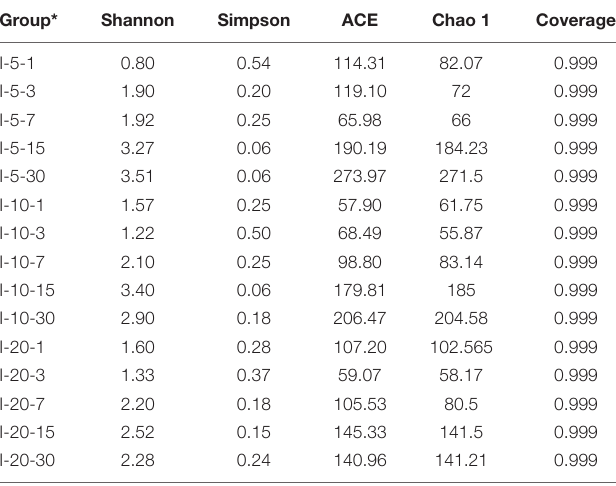
TABLE 4 | Variation of α diversity index under different inoculation volume.